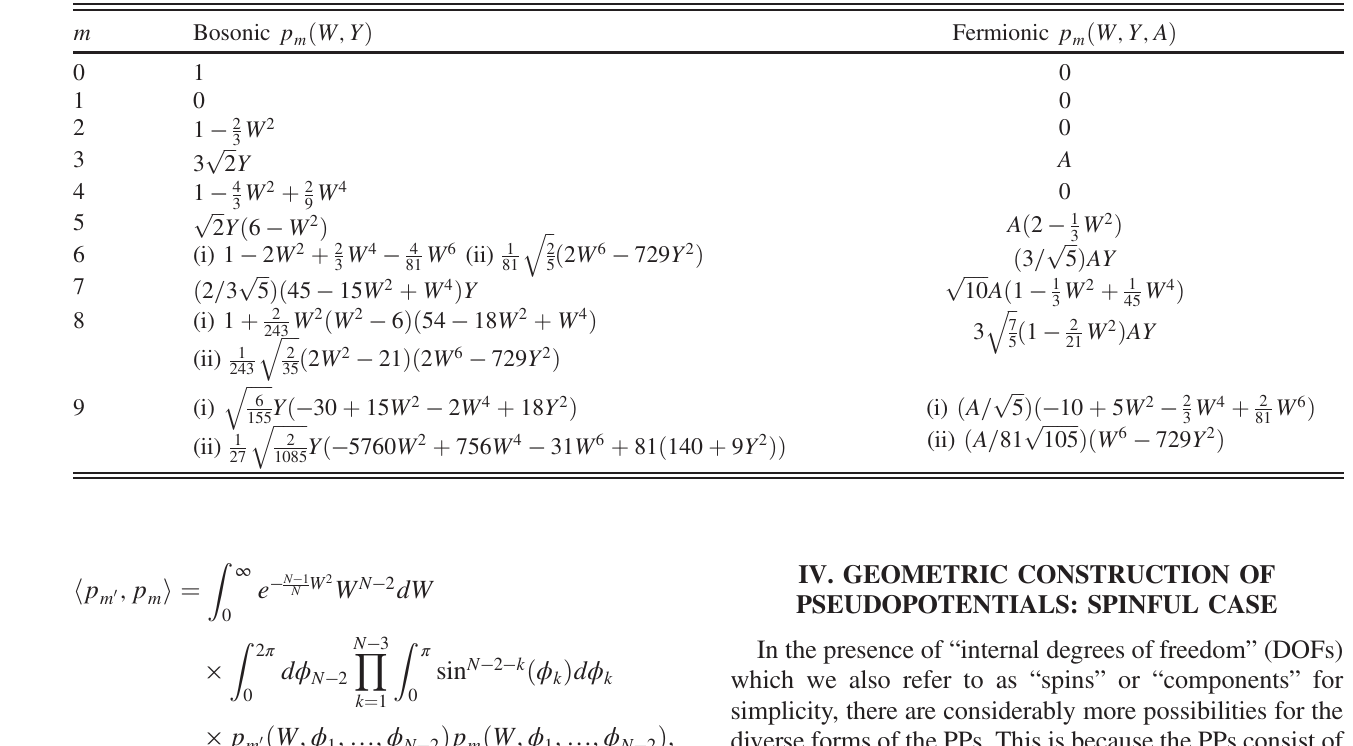
TABLE III. The polynomials p m for N ¼ 3 -body PPs for bosons and fermions up to m ¼ 9 . Note that there is more than one possible PP for larger m since there are multiple ways to build a homogeneous (anti)symmetric polynomial from the primitive and elementary symmetric polynomials. For instance, with Y and A defined in Eqs. (24) and (25), there are two possible bosonic PPs for m ¼ 6 since there are two ways ( W 6 and Y 2 ) to build a homogeneous 6-degree polynomial from elementary symmetric polynomials. For the fermionic cases, we have explicitly kept only one factor of A since even powers of A can be expressed in terms of W 2 and Y . For all cases, the mean-square spread of the PPs also increases linearly with m , i.e., κ 2 h Eq. (20)].